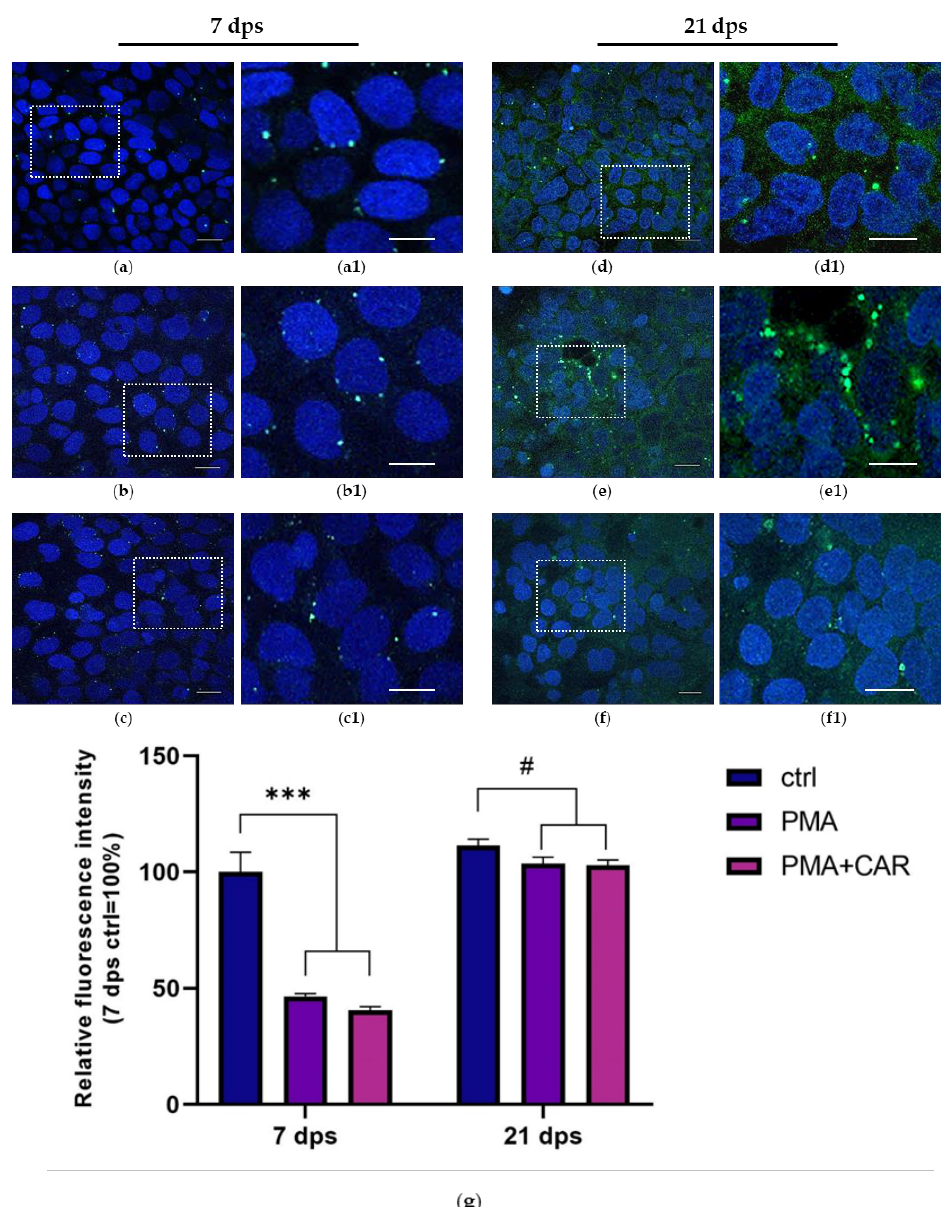
Figure 5. Fluorescence immunocytochemical analysis of AIF-1 protein localization in 7 and 21 dps Caco-2 monolayers treated with PMA (150 nM) or PMA+CAR (1 mM) for 48 h. Merged images show the anti-AIF-1 green-fluorescent signal and DAPI nuclear staining (blue). ( a – c ): undifferentiated Caco-2 monolayers at 7 dps, untreated ( a ), PMA-treated ( b ) and PMA+CAR-treated cells ( c ). ( d – f) : differentiated, enterocyte-like Caco-2 monolayers at 21 dps, untreated ( d ), PMA-treated ( e ) and PMA+CAR-treated cells ( f ). Rectangles in pictures ( a – f ) are further magnified in ( a1 – f1 ), respectively; magnification: 63×. Scale bar: 20 µm ( a – f ), 10 µm ( a1 – f1 ). Imaging by an LSM 700 confocal laser microscope (Zeiss, Dresden, Germany), Zen2012 Black Edition program. ( g ): quantitative analysis of AIF-1 fluorescence intensity (see Materials and Methods for detail). Data are presented as mean ± SEM of five measures from each of three independent biological replicates. Mean values are expressed as a percent with respect to the untreated control at 7 dps (100%). Significant differences are presented by individual symbols. #: vs. control at 21 dps. Statistical analysis: one-way ANOVA with Dunnett correction for multiple comparisons (# p ≤ 0.05; *** p < 0.001). At 21 dps, control cells in the monolayer displayed a homogeneous cytoplasmic dif- fused distribution of AIF-1 signal in association with some positive vesicles observed in the perinuclear area (Figure 5d). In 21 dps mature monolayers, PMA treatment resulted